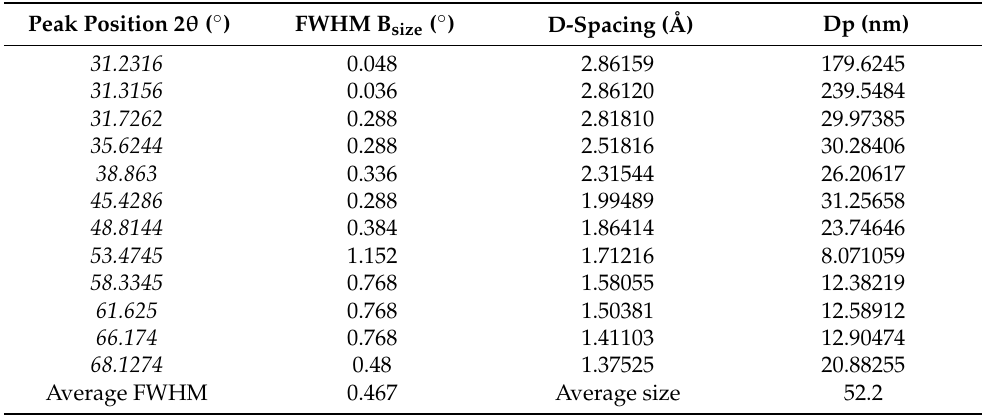
Figure 7. X-ray Diffraction of ZnO NPs. Table 4. CuO NPs average crystalline size calculation using Debye–Scherrer Equation.